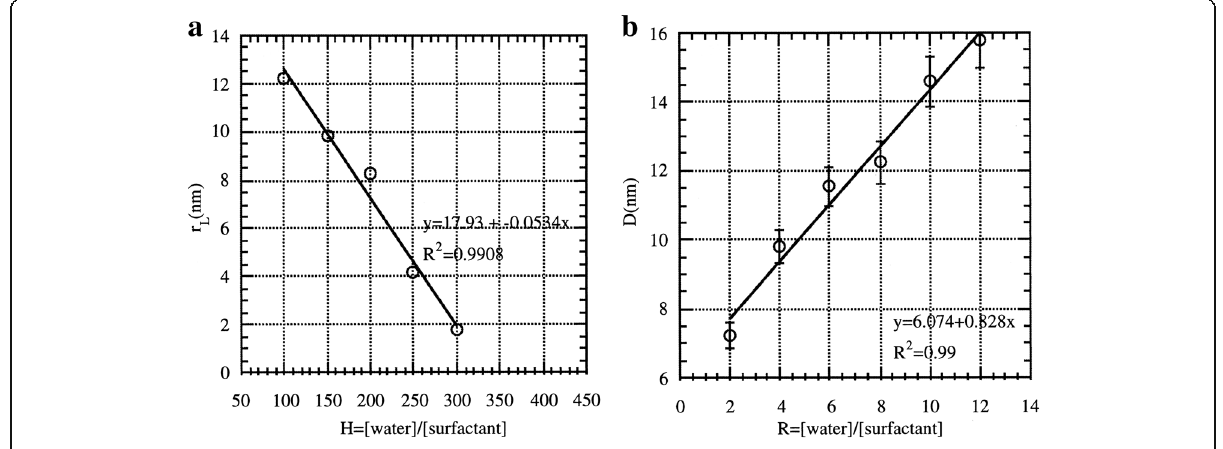
Fig. 7 a The size change as a function of H ( R = 4 and X = 1); b when R is variable, the size change of Ag clusters